Question: State the chart type depicted above.
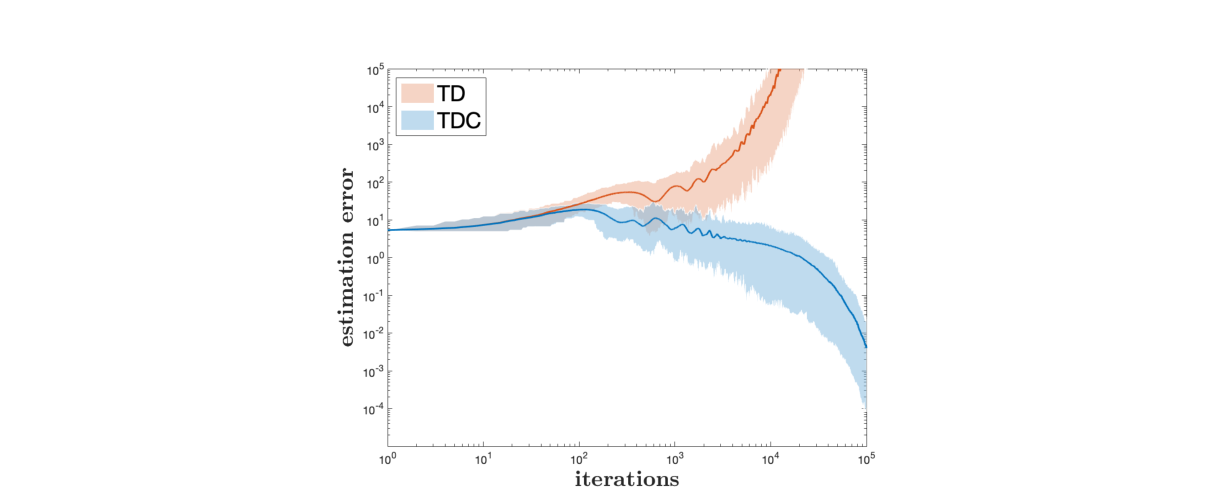
Answer: line